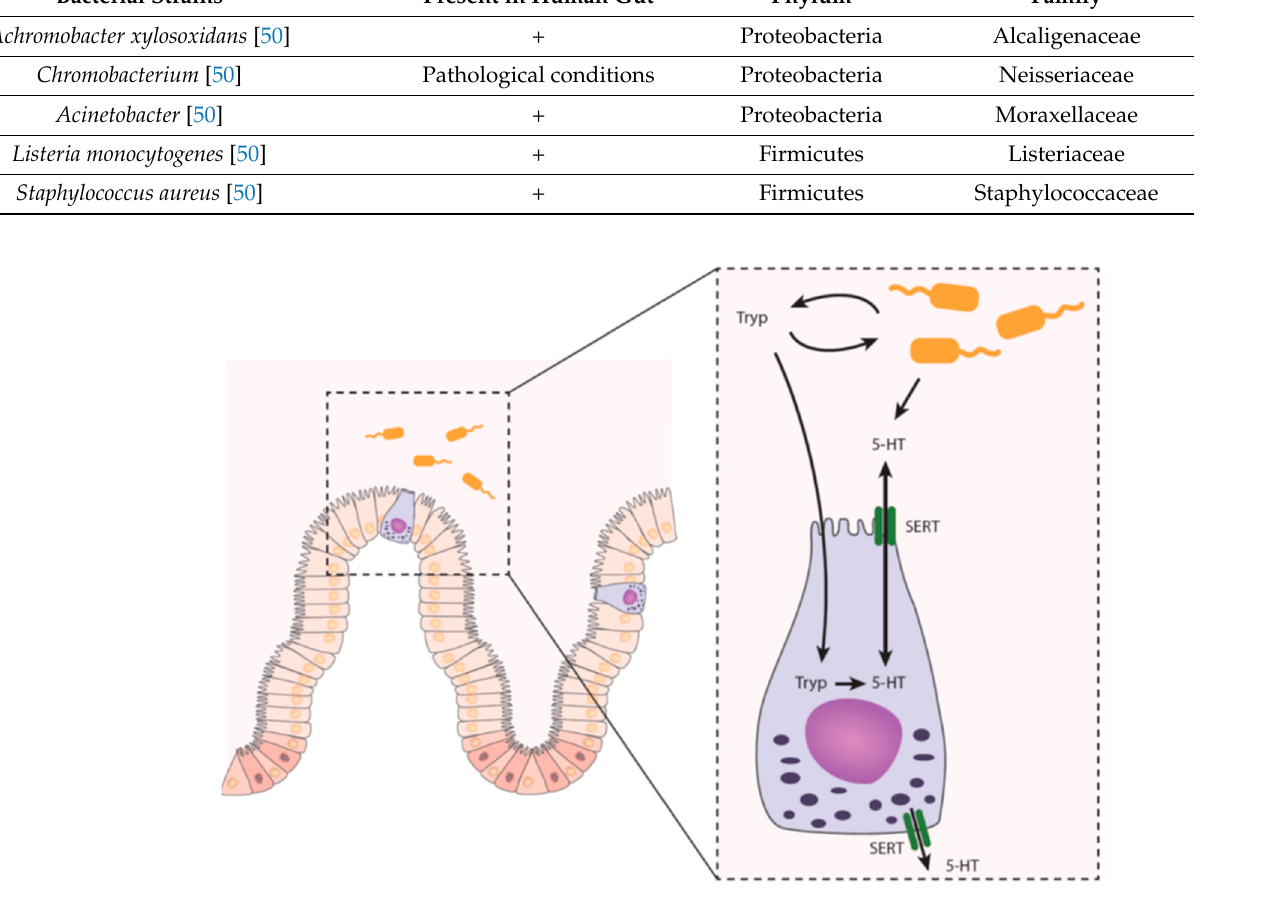
Figure 1. Intestinal 5-HT metabolism. Enteroendocrine cells in the gut epithelium synthesize 5-HT from tryptophan. This process is directly (via the availability of tryptophan) and indirectly (promotion of synthesis by microbial metabolites) regulated by the gut microbiota. The release of 5-HT is mediated by SERT. In addition, the gut microbiota might also be able to produce 5-HT. 5-HT: 5-hydroxytryptamine; SERT: serotonin reuptake receptor; Tryp: tryptophan. IBDs, including Crohn’s disease (CD) and ulcerative colitis (UC), are